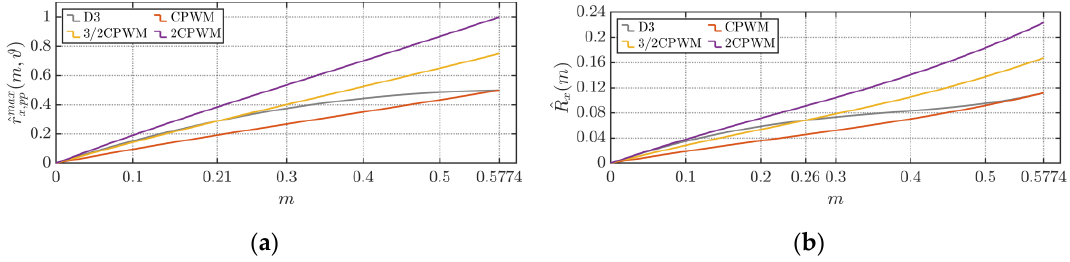
Figure 25. DPWM and CPWM compensated comparison of the normalized current ripple: ( a ) maximum peak-to-peak value; ( b ) rms. Average switching frequency compensation is labeled as “3 / 2 CPWM”. Switching losses compensation is marked as “2CPWM”. The normalization base V dc / (2 Lf sw ) has been used.